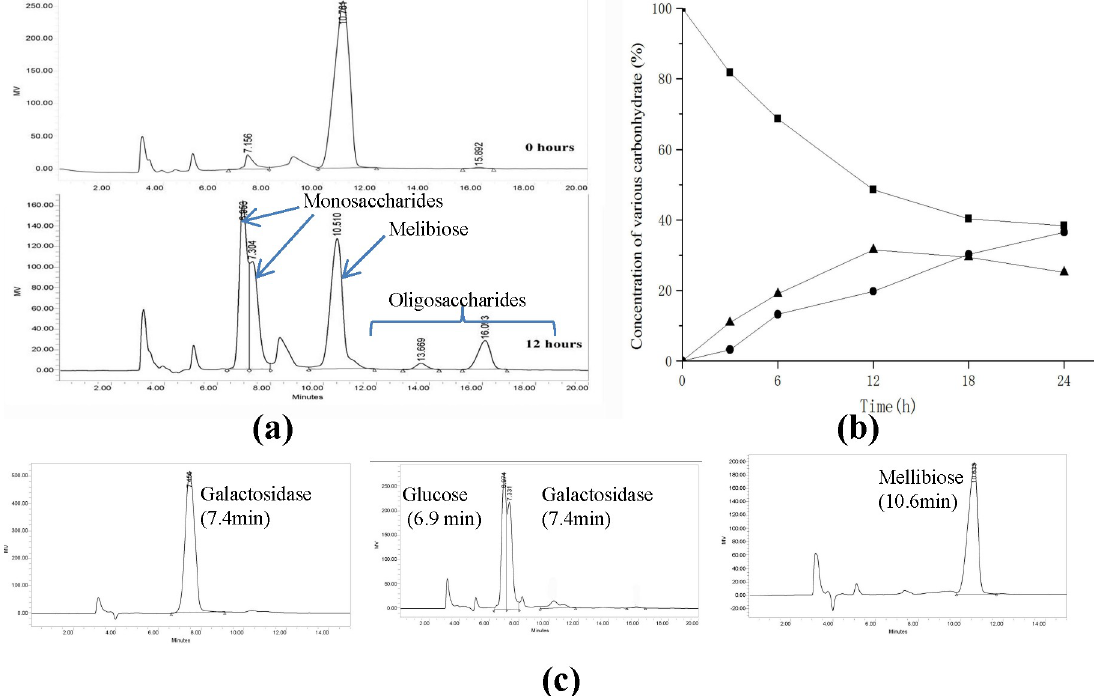
Fig 5. HPLC analysis of GOS synthesized by AglB (a), the time course of melibiose conversion (b), and the retention time of glucose, galactose, and melibiose (c). ( ■ ) Melibiose, ( ● ) Monos accharide, ( ▲ ) Oligosaccharides (retention time13.7 min and 16.0 min).